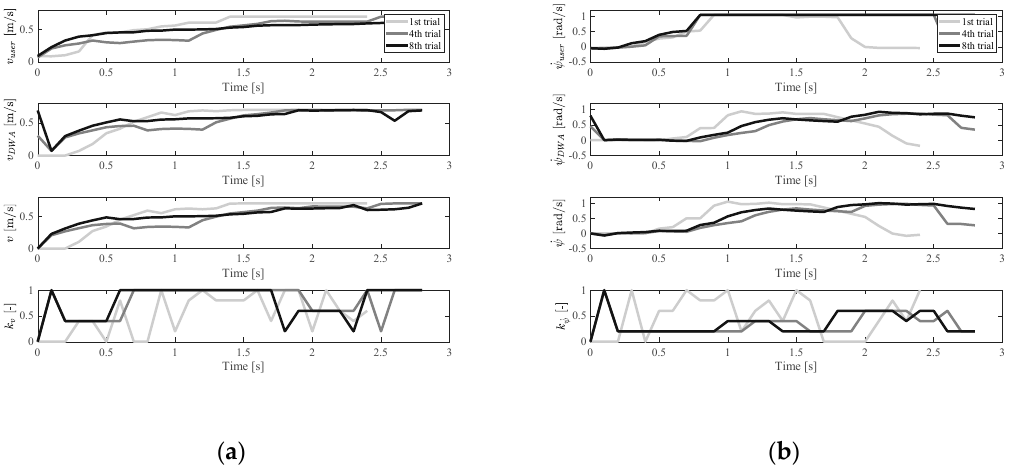
Figure 15. Velocity and control weight change in the oversteer case (active user): ( a ) (cid:1874) (cid:3048)(cid:3046)(cid:3032)(cid:3045) ,(cid:1874) (cid:3005)(cid:3024)(cid:3002) , (cid:1874), and (cid:1863) (cid:3049) change , ( b ) (cid:2032)(cid:4662) (cid:3048)(cid:3046)(cid:3032)(cid:3045) , (cid:2032)(cid:4662) (cid:3005)(cid:3024)(cid:3002) , (cid:2032)(cid:4662),and (cid:1863) (cid:3103)(cid:4662) change.